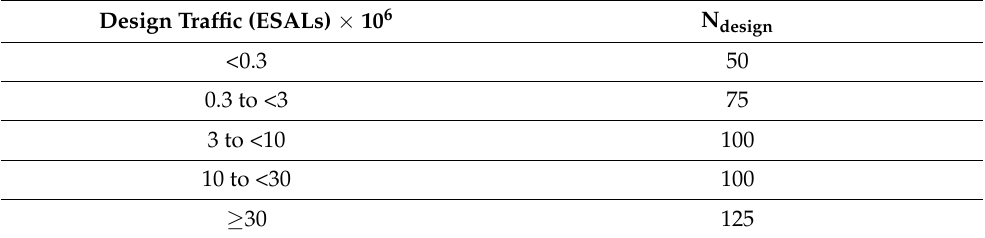
Table 10. Levels of N design according to NCHRP-714.